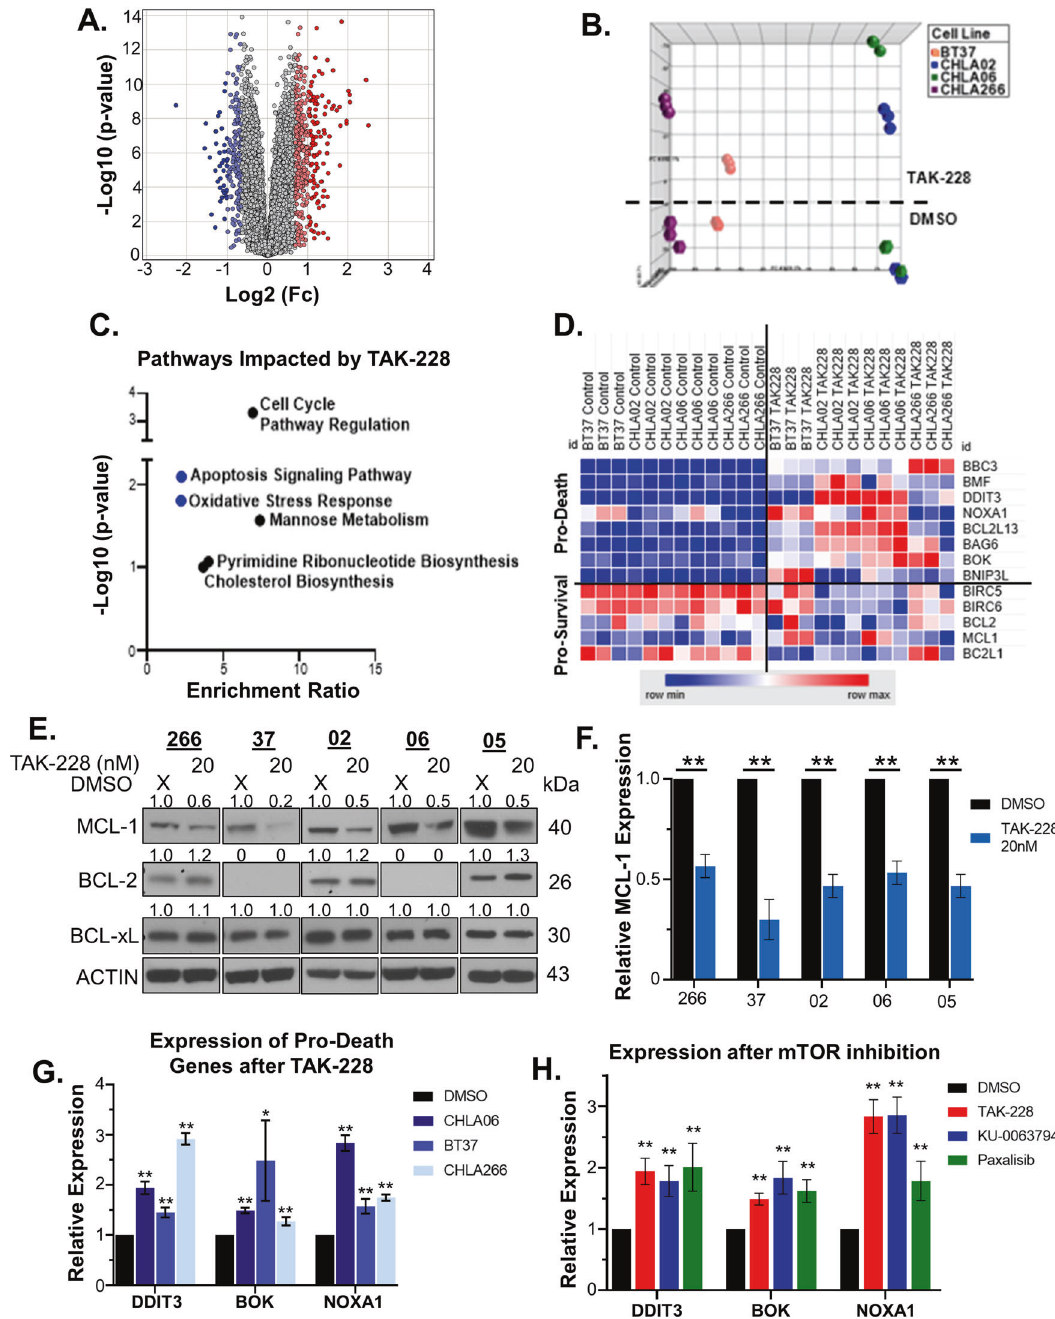
Fig. 1 TAK-228 disrupts the apoptotic signaling pathway and oxidative stress response in AT/RT. A Volcano plot of the combined data over all cell models illustrates the impact of 4 h of TAK-228 20 nM treatment on gene expression. Genes included with FDR cutoff <0.1 and >25% change in expression. B Principal component analysis of gene expression pro fi les. Hexagons below the dashed line represent DMSO control-treated cells. Circles above the line represent TAK-228-treated cells. C Panther pathway analysis on genes downregulated after TAK-228 treatment identi fi ed signaling pathways most signi fi cantly disrupted by TAK-228 treatment. D Heatmap shows the most divergently expressed genes related to the apoptotic signaling pathway between DMSO and TAK-228-treated cells. Blue represents minimal expression and red maximum. RNASeq values normalized to the average value of the DMSO-treated samples in each cell model. E Western blot for anti-apoptotic proteins 24 h after TAK-228 20 nM treatment. Numbers above blots represent quanti fi cation of protein expression normalized to ACTIN. F Relative expression of MCL-1 as determined by quanti fi cation of western blots 24 h after TAK-228 treatment. MCL-1 expression is normalized to ACTIN and expressed as a ratio to DMSO control. G RT-PCR probing for pro-apoptotic genes DDIT3, BOK , and NOXA1 24 h after TAK-228. Signi fi cance measured in comparison with DMSO control. H Expression of pro-apoptotic genes 24 h after treatment with the mTOR/PI3K inhibitors TAK-228, KU-0063794, and Paxalisib dosed at the IC 50 in CHLA06. Signi fi cance as compared with DMSO control. Results in this fi gure are presented as the mean + / − SEM, * p < 0.05 ** p < 0.005, t-